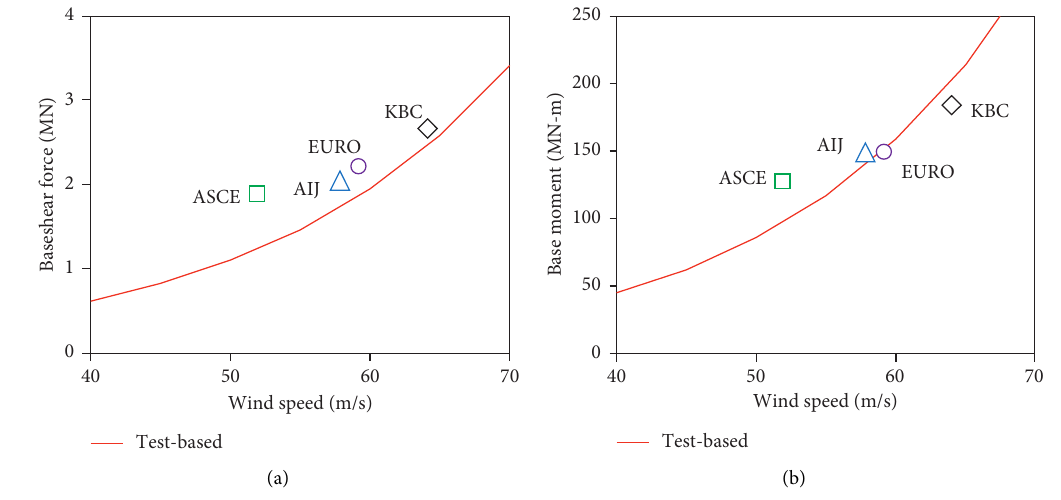
Figure 17: (a) Base shear forces and (b) base moments vs. wind velocity at 120m.